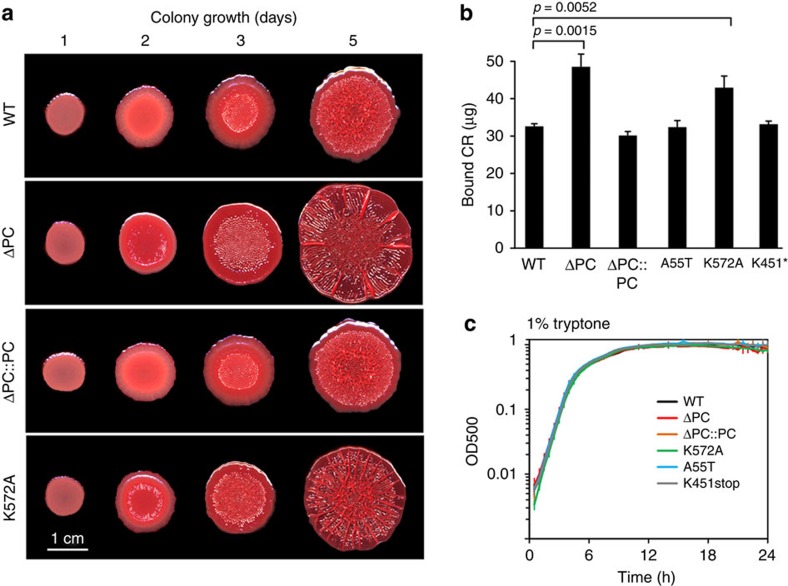
PaPC dysfunction leads to increased matrix production and altered colony morphology.(a) Colony morphology of wild-type P. aeruginosa PA14, ΔPC, the PC-complemented strain and the K572A mutant on 1% tryptone, 1% agar (supplemented with Congo red and Coomassie blue). (b) Quantification of Congo red binding, a proxy for matrix production, for P. aeruginosa PA14, ΔPC, the PC-complemented strain and various site-specific mutants grown on 1% tryptone, 1% agar with no added dyes. Colonies were grown for 3 days before they were collected for the Congo red binding assay. (c) Shaken liquid-culture growth of P. aeruginosa PA14, ΔPC, the PC-complemented strain and various site-specific mutants in 1% tryptone. Each growth curve represents the average of three biological replicates. Error bars denote s.d.